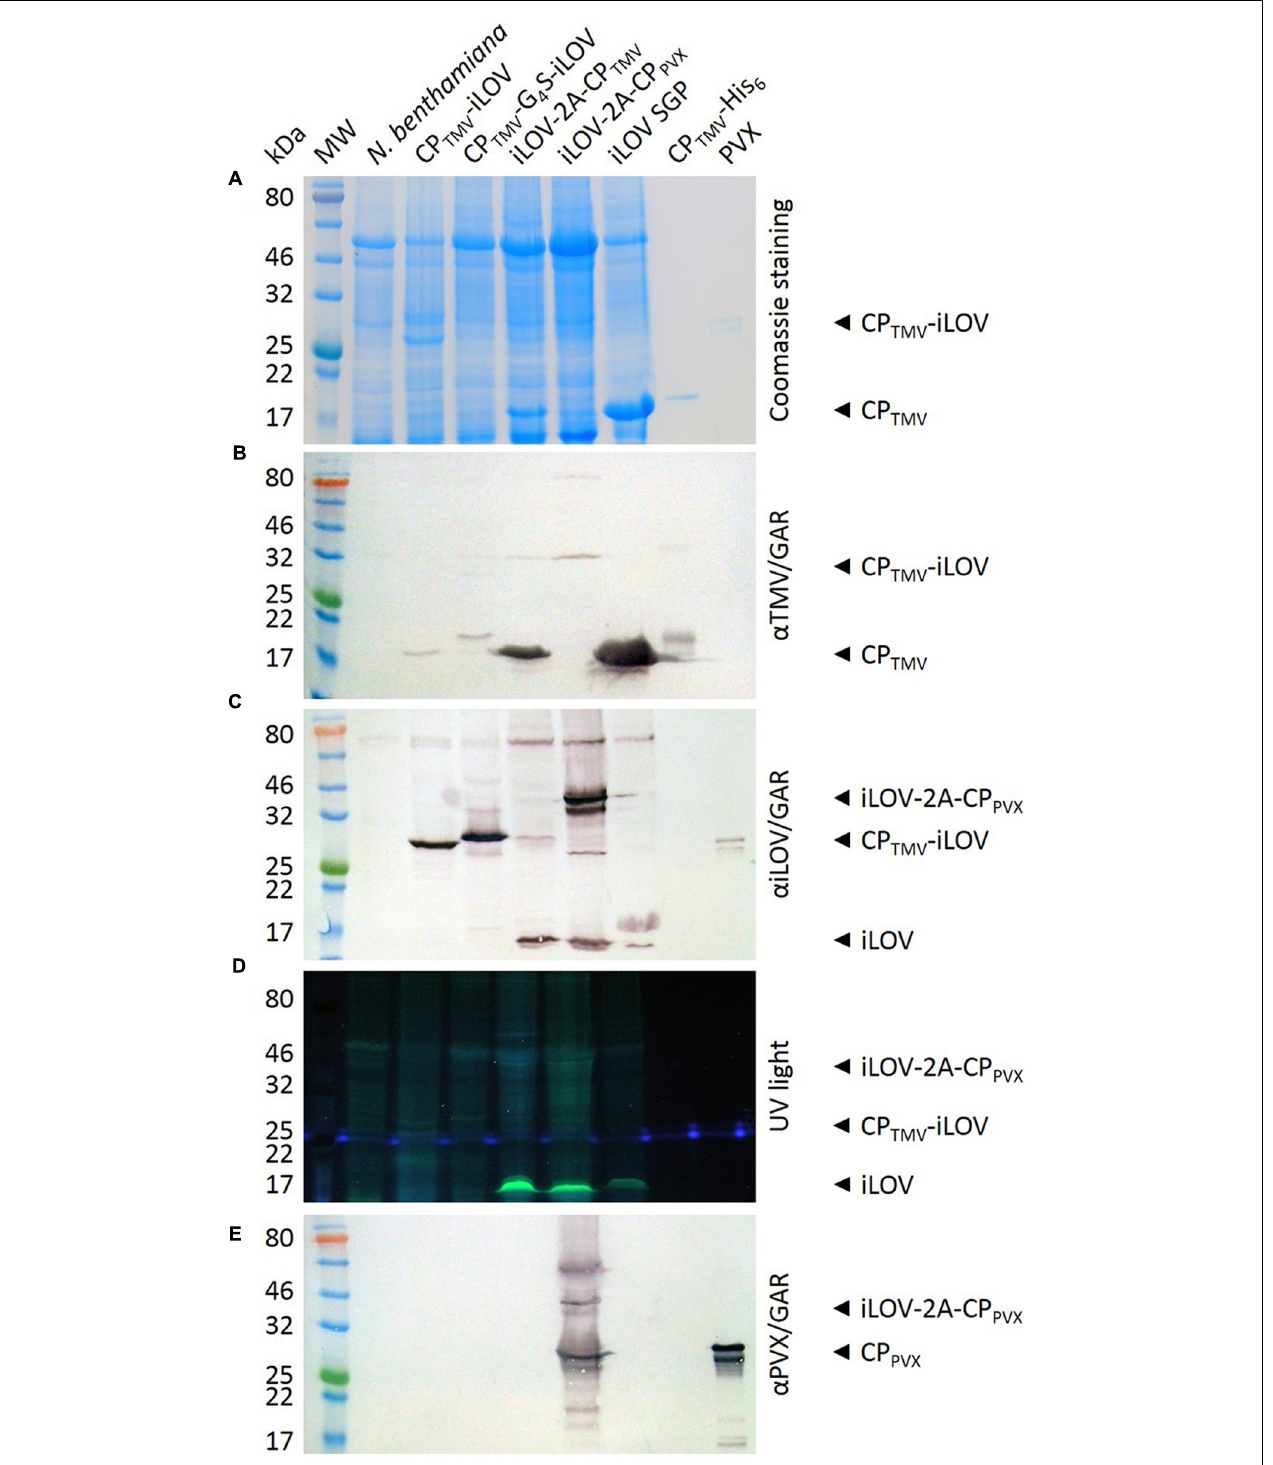
FIGURE 3 | Analysis of infected N. benthamiana leaves expressing iLOV fusion proteins. Extracts of systemically infected leaf extracts were separated by SDS-PAGE (20- µ l samples) and proteins were (A) stained with Coomassie Brilliant Blue G250, (B,C,E) transferred to a nitrocellulose membrane for western blotting, or (D) detected under UV light. MW = P7712 Pre-stained Protein Standard, N. benthamiana = extract from non-infected leaf. CP TMV -His = TMV CP-His (control), PVX = PVX particles. Other lanes are extracts from leaves infected with the corresponding viral vectors. Antibody detection: (B) TMV-specific antibody and GAR AP , (C) iLOV-specific antibody and GAR AP , (E) PVX-specific antibody and GAR AP .